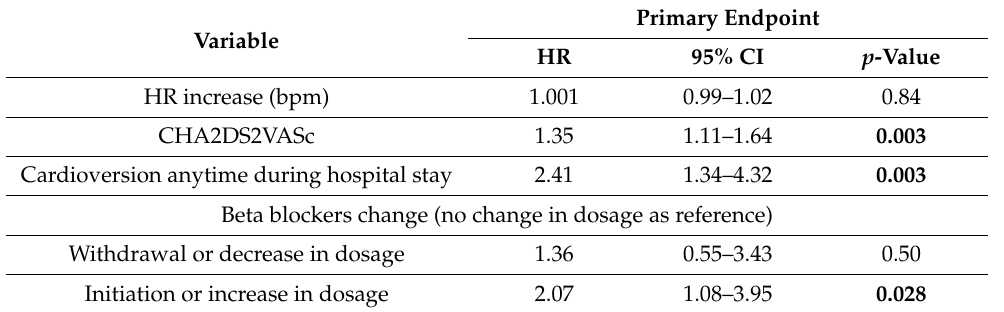
Table 3. Multivariable analysis of predictors of AF recurrence.